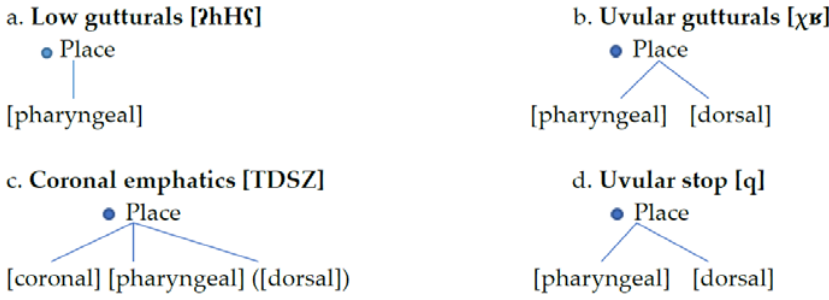
Figure 5. Representation of gutturals McCarthy (1994, p. 221).